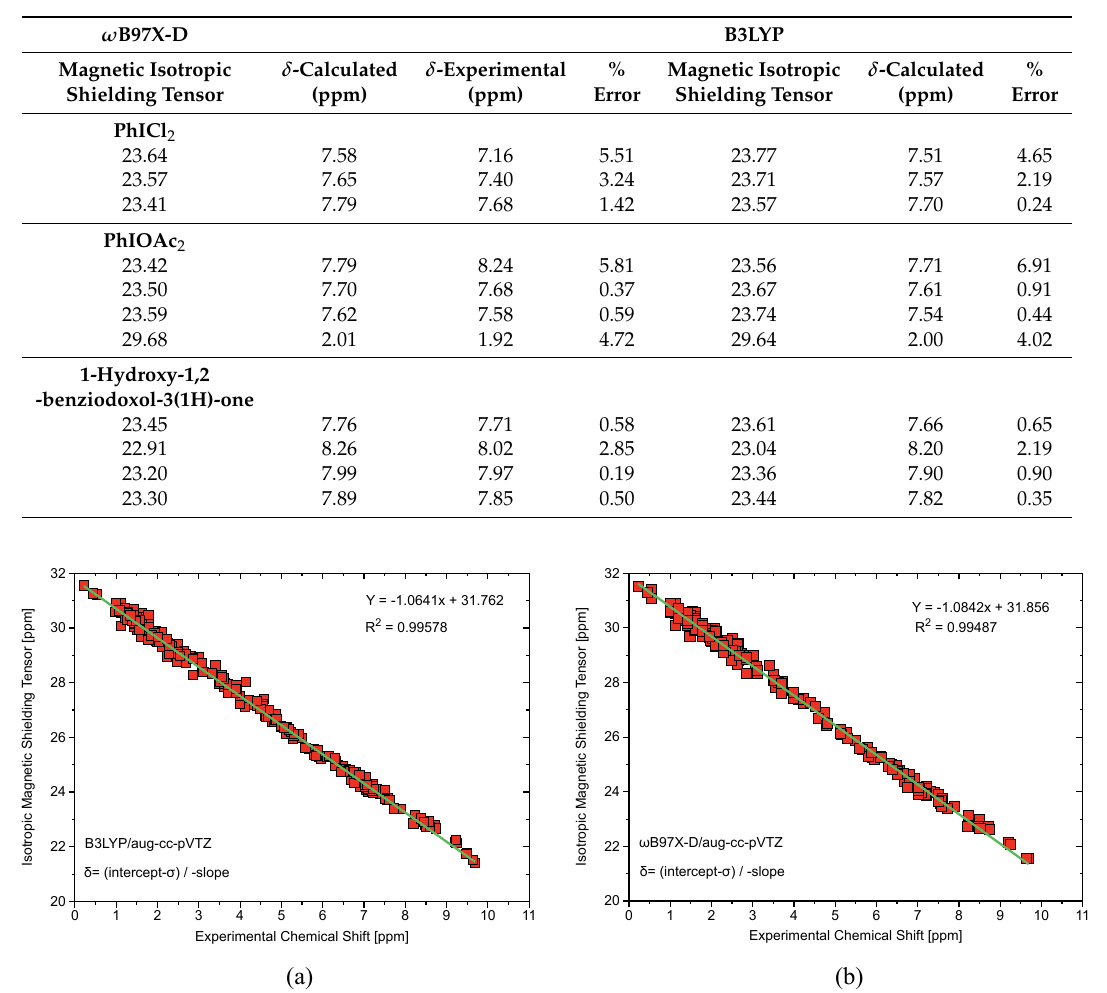
Table A4. Calculated and experimental NMR chemical shifts for PhICl 2 , PhI(OAc) 2 , and